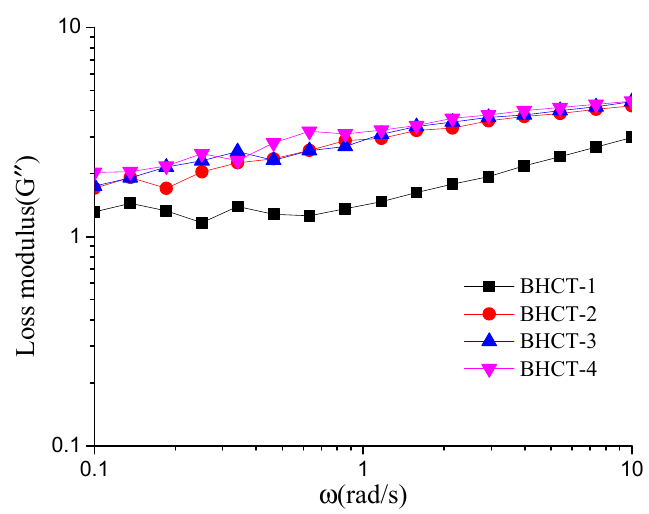
Figure 15. Loss modulus of composite gel with different crosslinker contents.